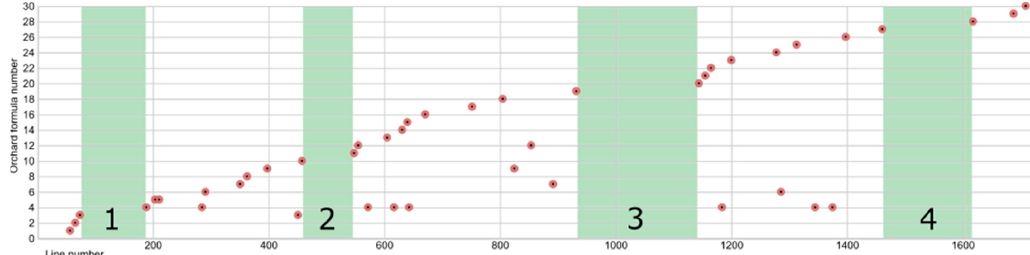
Figure 1. The distribution of Cynewulfian formulae in Andreas .